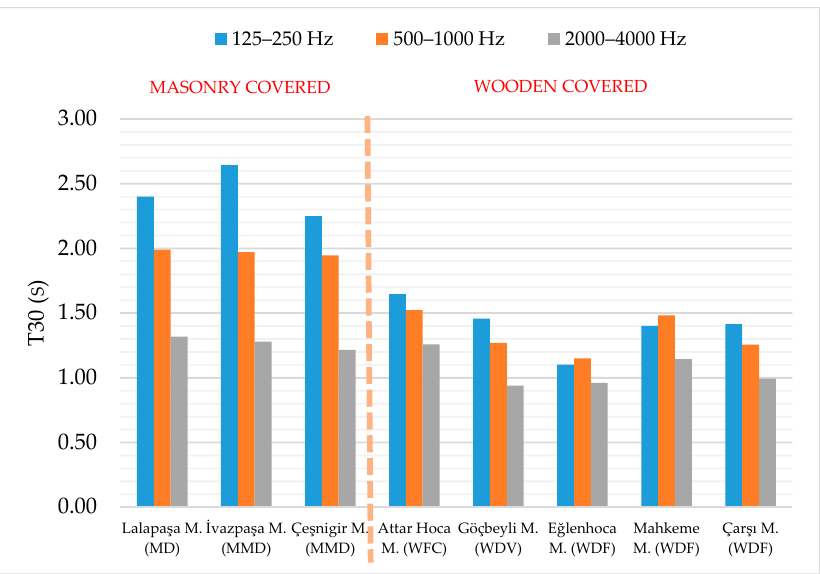
Figure 12. The average T30 values of mosques at low, mid, and high frequencies.